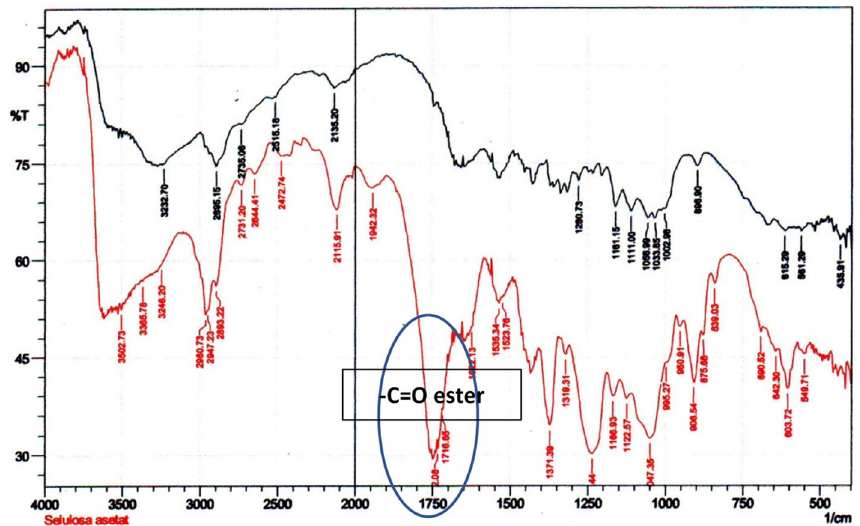
Figure 12. Infrared spectra of cellulose obtained from nata de coco (black) modified cellulose by acetylation (red).